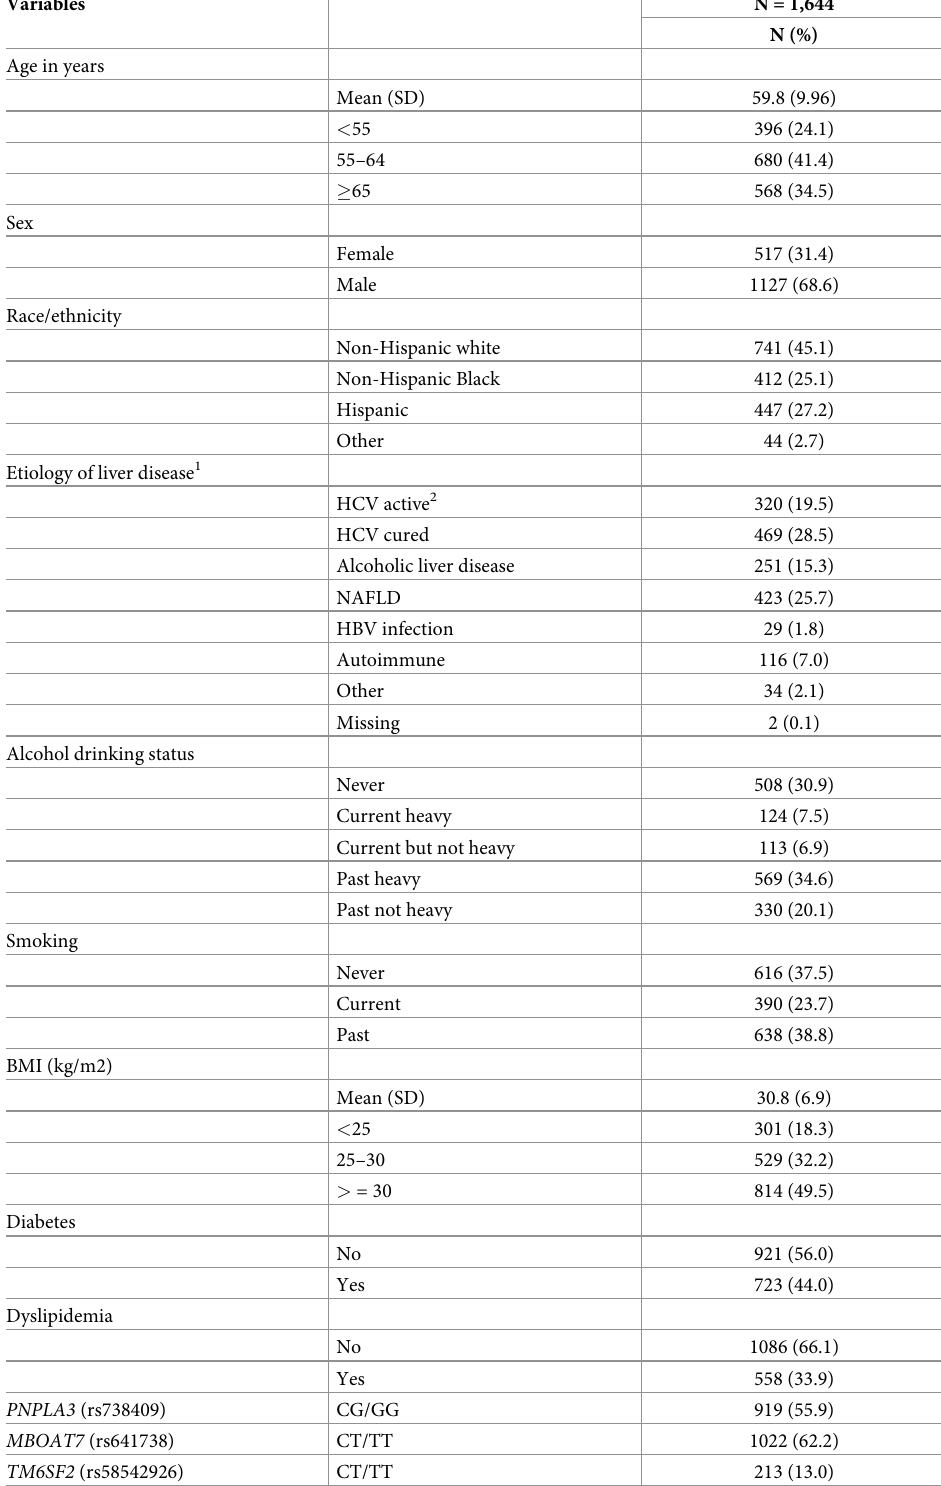
Table 1. Select characteristics of the study